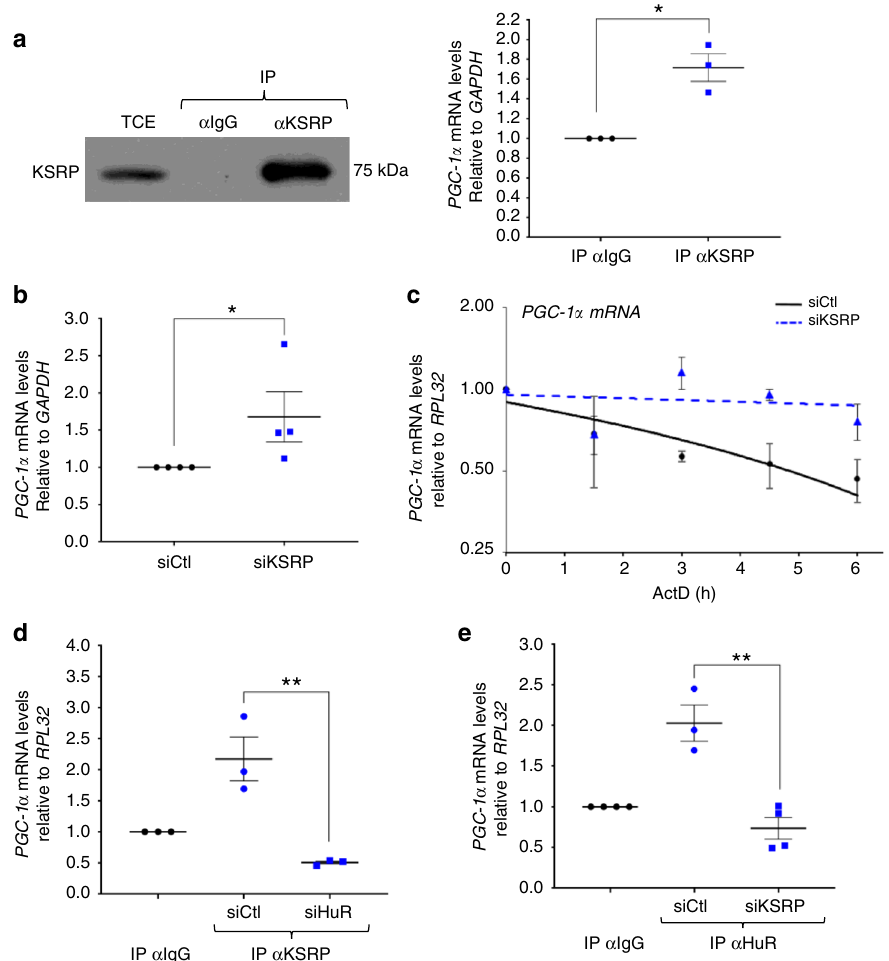
Fig. 7 KSRP collaborates with HuR to destabilize the PGC-1 α mRNA in muscle cells. a Left panel: western blot demonstrating the immunoprecipitation (IP) of KSRP using an anti-KSRP antibody or IgG as a negative control. Right panel: RT-qPCR experiments were performed to determine the association of PGC - 1 α mRNA to immunoprecipitated KSRP. Normalized PGC-1 α mRNA levels were plotted relatively to the IgG negative control ( n = 3). b Total RNA was isolated from C2C12 myoblasts treated with or without siKSRP and relative PGC-1 α expression was assessed by RT-qPCR. PGC-1 α mRNA level were standardized against GAPDH and plotted relatively to the siCtl condition ( n = 4). c The stability of the PGC-1 α mRNA was determined in muscle cells depleted or not of KSRP and treated with Actinomycin D (ActD) for 0, 1.5, 3, 4.5, or 6 h. mRNA levels were then standardized against RPL32 mRNA levels and plotted relative to the abundance of mRNA at time 0 of ActD treatment (which is represented as 1) ( n = 3). The line of best fi t was determined by linear regression using the data points for siCtl and siKSRP. Error bars represent ± S.E.M. d , e IP coupled to RT-qPCR experiments was performed using anti- KSRP ( d ) or anti-HuR ( e ) antibodies on total extract from C2C12 myoblasts treated with siHuR ( d ), or siKSRP ( e ). PGC-1 α mRNA levels in the samples immunoprecipitated with anti-KSRP or anti-HuR were normalized to the corresponding IgG sample. The results are presented as mean ± S.E.M, ** p < 0.01 unpaired t -test. d ( n = 3), e ( n = 4 for IPIgGsiCtl, IPIgG siKSRP, and IPHuR siKSRP; n = 3 for IPHuR siCtl). Source Data for all panels are provided in